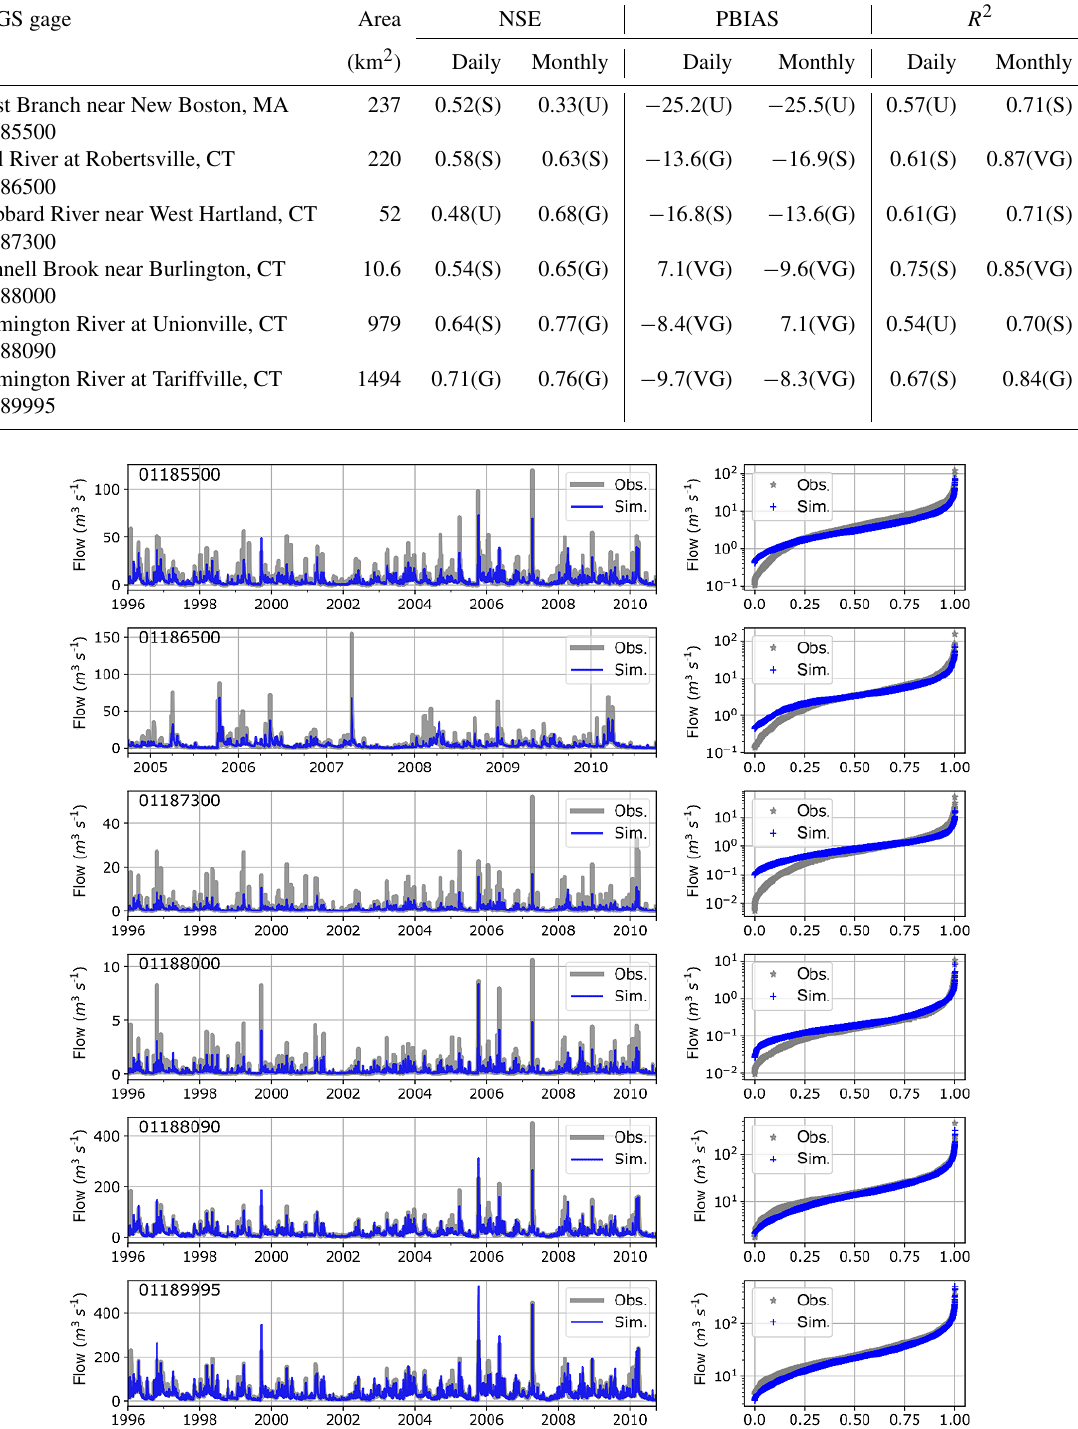
Table 4. USGS gage stations in the Farmington River basin (Fig. 1) and model performance evaluation criteria for daily and monthly flows simulated by DHSVM based on performance ratings from Moriasi et al. (2007). (VG – Very Good, G – Good, S – Satisfactory, U – Unsatisfactory.)